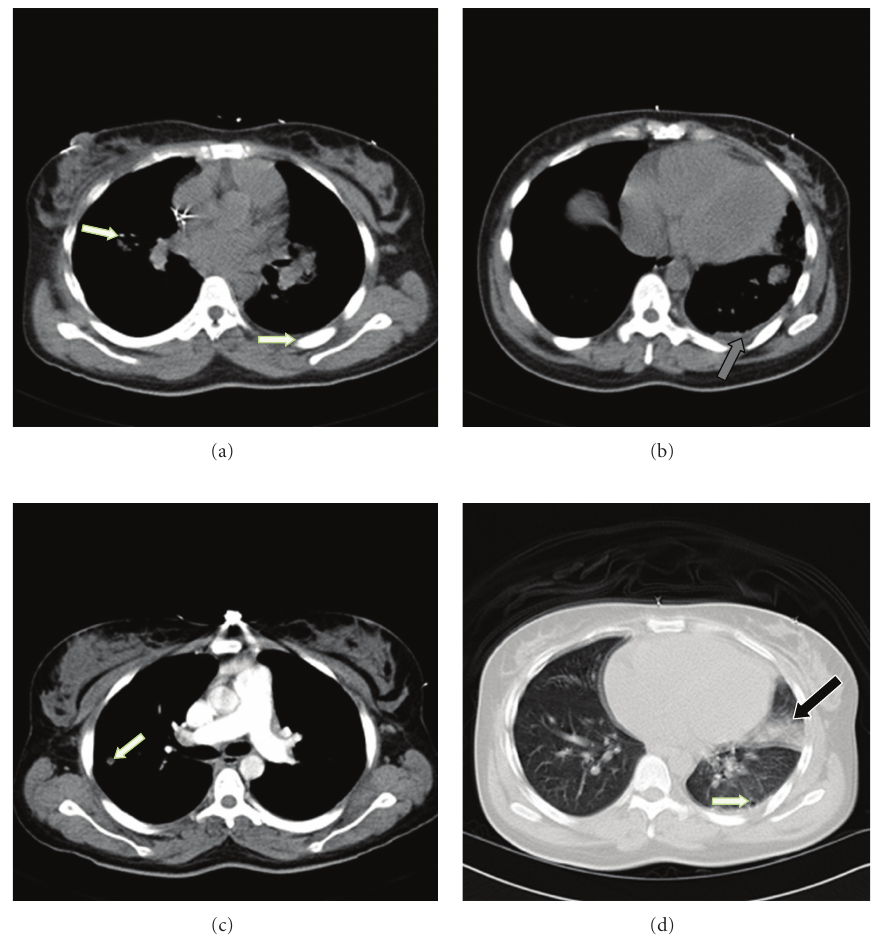
Figure 2: White shows cavitary and non-cavitary small nodular lesions changes consistent with pulmonary septic embolization and the black arrow shows a small left pleural e ff usion. Black and white arrow is showed a complicated ligulae